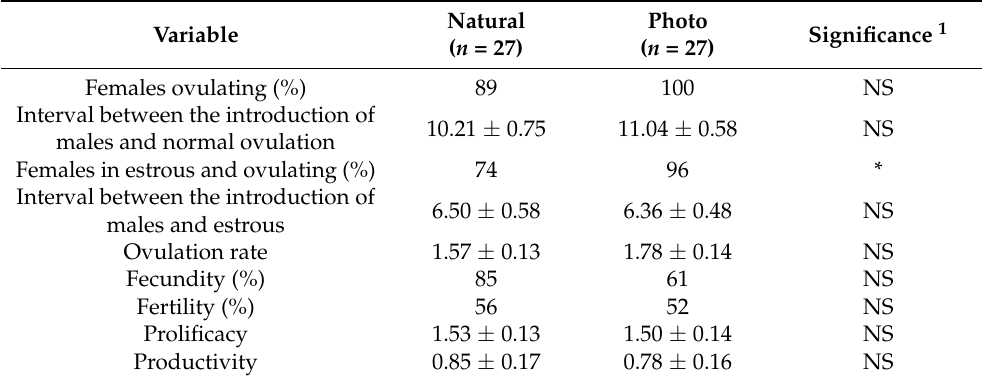
Table 1. (Experiment 1). Reproductive responses of females submitted to the male effect using photoperiod-treated males, i.e., long days for three months between November and February (Photo) or males subjected to natural photoperiod (Natural). Natural Photo Variable Significance 1 ( n = 27) ( n = 27) Females ovulating (%) 89 100 NS 10.21 ± 0.75 11.04 ±